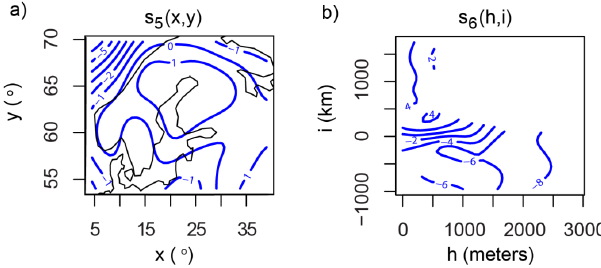
Figure 4. Components of the GAM model in Eq. (4) fitted to down- scale the CLIMBER-2 July mean temperature in the recent past, MIS 3 stadial and LGM climates. The blue curves show the es- timated effects of (a) longitude and latitude, and (b) elevation and distance to the nearest ice sheet (or ice cap) margin. In ice-free areas the distance was expressed by positive values and in areas covered by ice the distance was expressed by negative